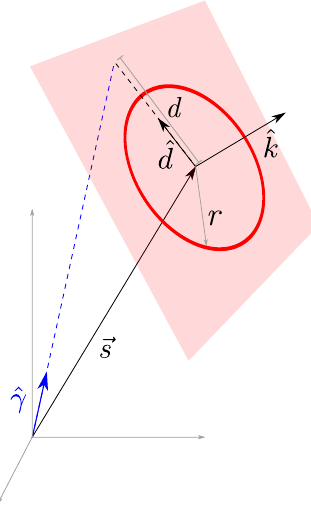
Figure 2 . A schematic (cid:12)gure showing the string loop in the sky and the various parameters used to describe it. The red circle is the axion string loop while the blue line shows the photon direction. ~s gives the location of the center of the string loop, r is its radius, ^ k is the orientation, ^ (cid:13) is the direction the CMB photon is coming from, and d is the distance between the photon trajectory and the loop center measured in the plane of the loop (red shaded